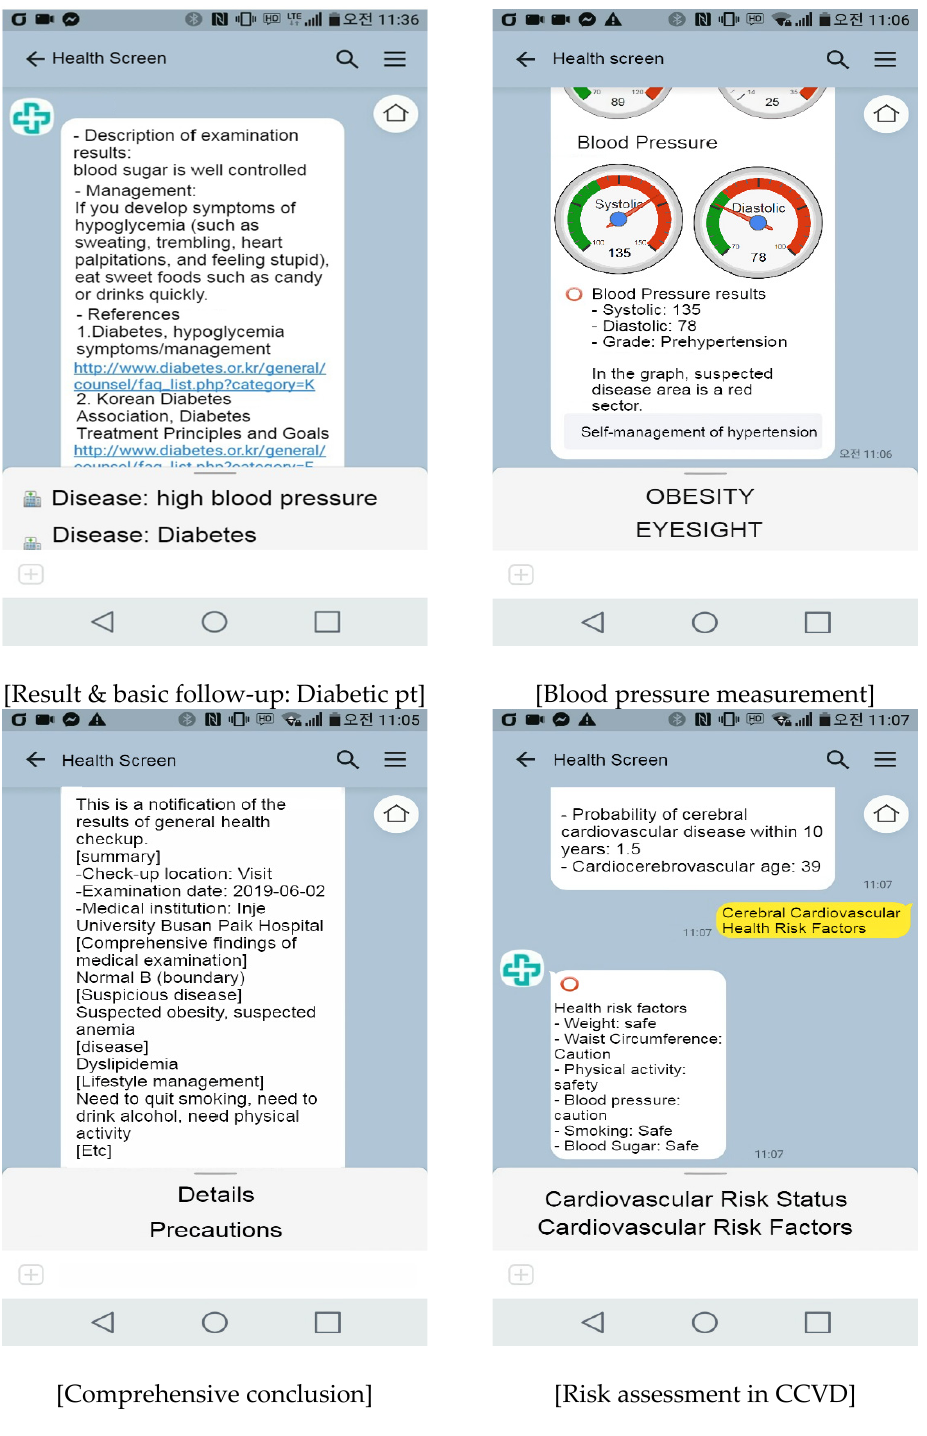
Figure 2. Contents of the chatbot program implemented on a smartphone.